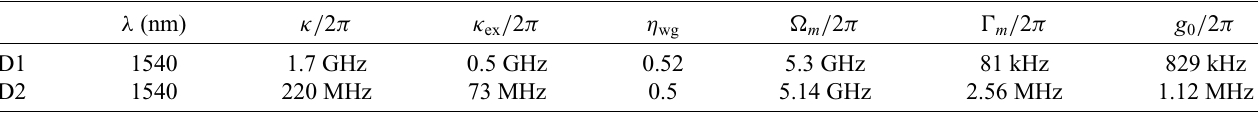
TABLE I. Detailed characterized parameters of the two tested OMC devices D1 and D2. D1 is measured at approximately 8 K with a pressure of 0.5 mbar, while D2 is measured at ambient